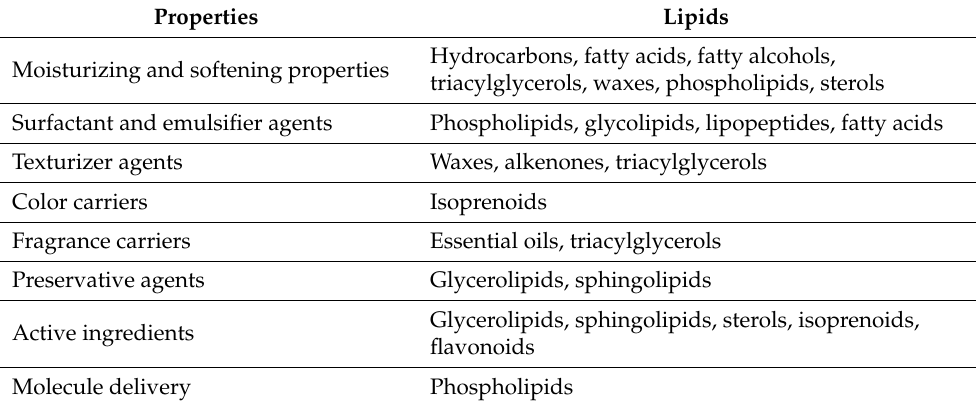
Table 1. Properties and lipid molecules most common in cosmetic